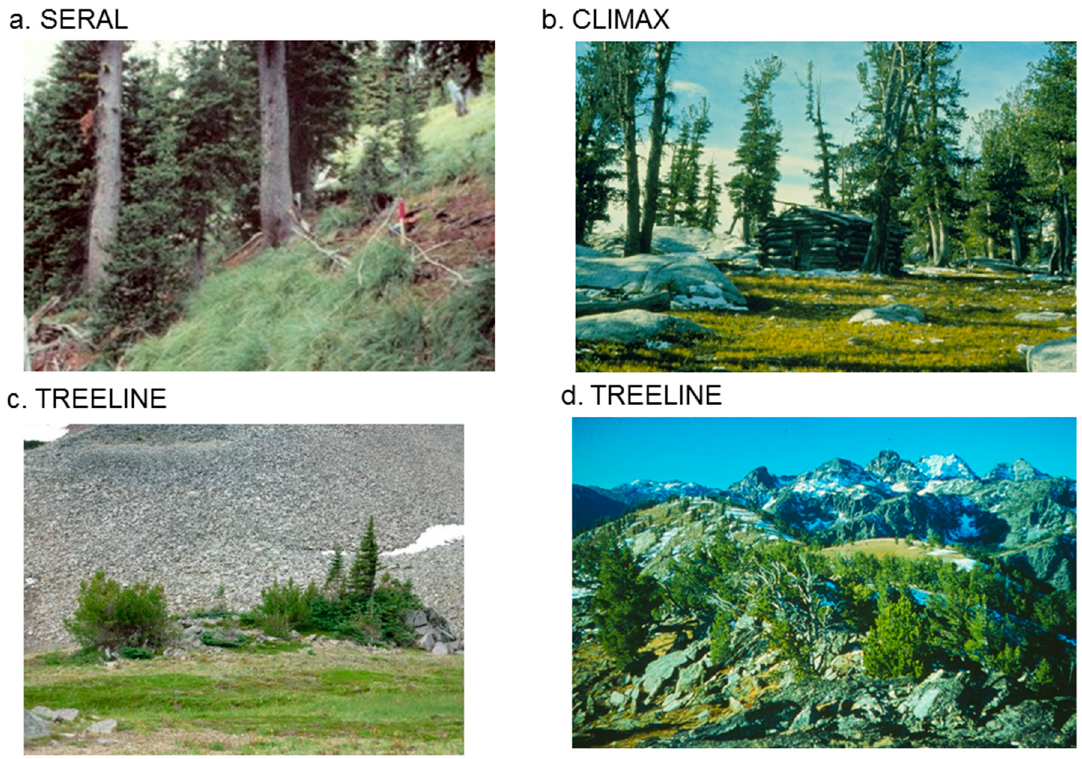
Figure 3. The three site types used in this report to stratify wildfire management actions: ( a ) seral (whitebark pine is seral to fir, spruce, hemlock), ( b ) climax (whitebark pine is the only dominant able to grow into a forest), ( c ), and ( d ) treeline.